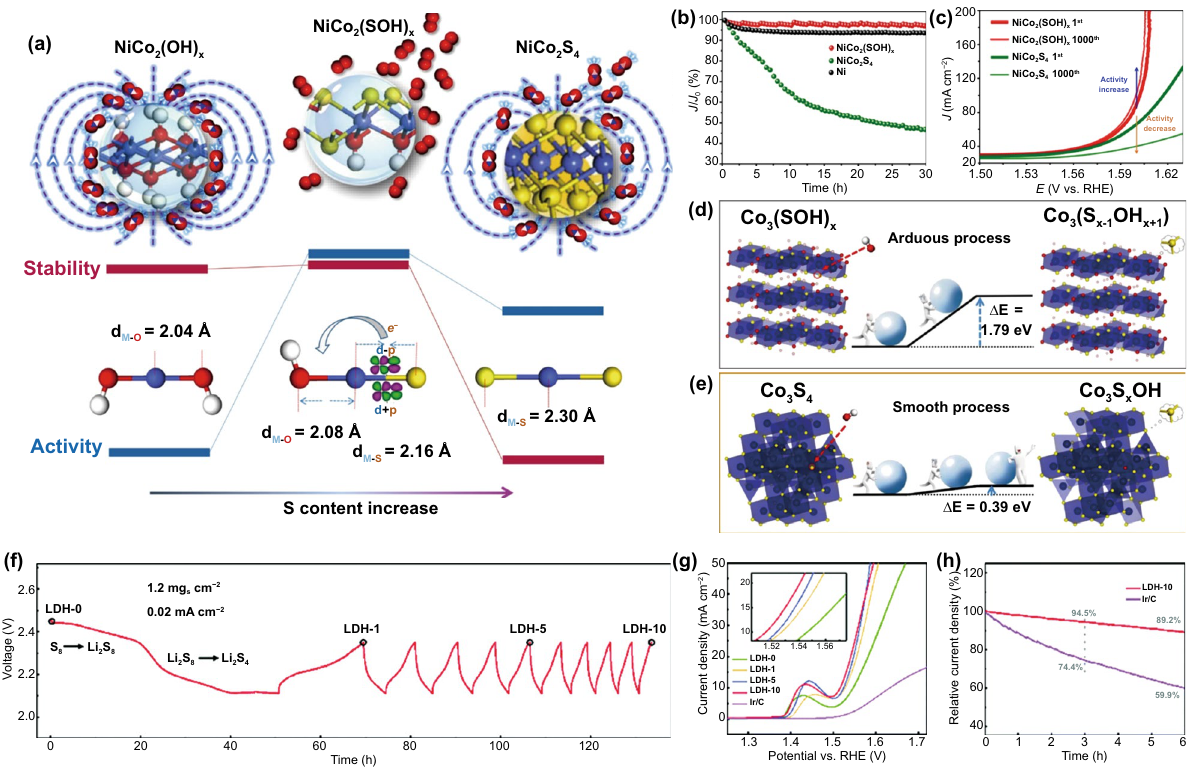
Fig. 12 a Ultimate unity of OER performance of NiCo 2 (S x OH 2− x ) y . Here, Co, S, O, and H atoms are shown in blue, yellow, red and white, respectively, b Chronoamperometric curves of Ni, NiCo 2 (SOH) x and NiCo 2 S 4 at a current density of 100 mA cm −2 , c first and 1000th polariza- tion curves of NiCo 2 (SOH) x and NiCo 2 S 4 . d, e Total energy change during the desulfuration process of S 2– in Co 3 S 4 (upper) and Co 3 (SOH) x (bottom) replaced by OH – . The non-spontaneous process of Co 3 (SOH) x with a more positive energy change discloses a more thermodynamic stable structure of Co 3 (SOH) x compared to Co 3 S 4 . Reprinted with permission from Ref. [61]. Copyright Year 2017, American Chemical Society. f Electrochemical anionic regulation process. Galvanostatic discharge/charge curves of the Li–S cell reactor, g 95% iR-compensated LSV curves of the LDH-x and Ir/C electrocatalysts at a scan rate of 10.0 mV s −1 and the rotation rate of 1600 rpm in O 2 -saturated 0.10 M KOH electrolyte, h Chronoamperometric response of the LDH-10 and Ir/C electrocatalysts for stability evaluation. Reprinted with permission from Ref. [172]. Copyright Year 2020, Royal Society of